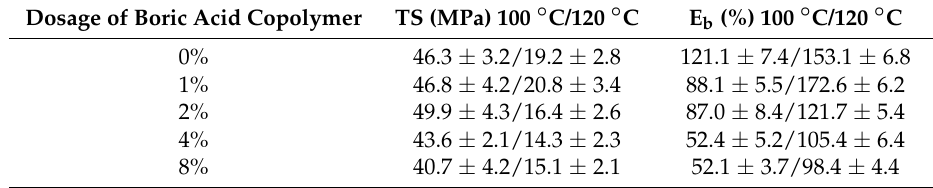
Table 3. Mechanical properties of as-prepared membranes (after heating at 100 °C and 120 °C, respectively; dry).